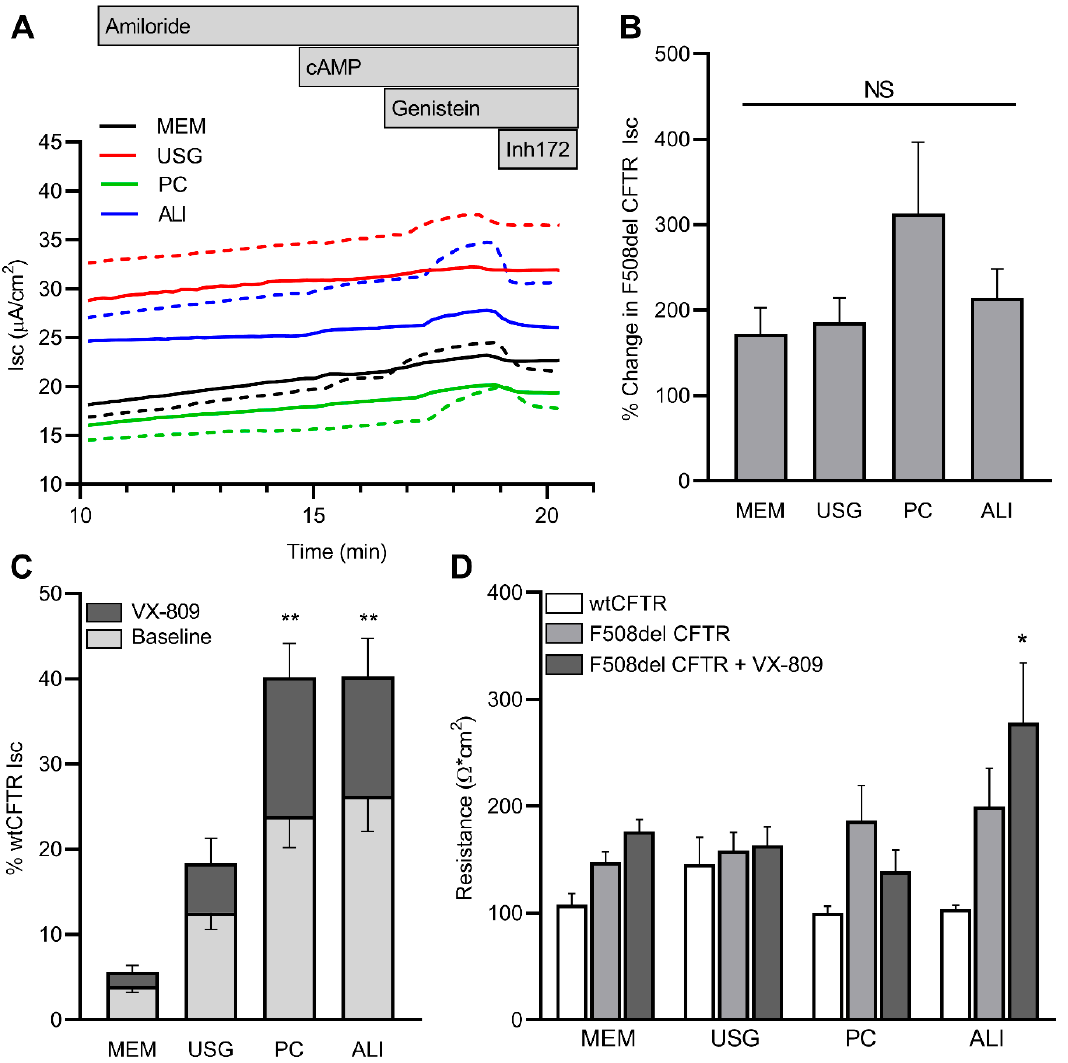
Figure 5. Media selection does not alter F508del CFTR rescue by VX-809; however, it does impact normalization of modulated CFTR function against wtCFTR. Cells grown in four media and treated for 72 h with vehicle or VX-809 were mounted in Ussing chambers and CFTR function was quantified under voltage clamp conditions. Representative tracings of corrected (dashed) and uncorrected (solid) F508del CFTR are shown in ( A ), while the VX-809-induced improvement in CFTR function is quantified in ( B ) as a relative change compared to vehicle. When normalized against media-specific wtCFTR function, there is a significant apparent difference in baseline (light grey) and VX-809-modulated (dark grey) F508del CFTR function ( C ); CFTR function is defined as cAMP- and genistein-dependent Isc, as presented in Figure 4B,D. Baseline resistance measurements for all conditions are shown in ( D ), with only VX-809-treated F508del inserts grown in ALI media being statistically different across the cohort. n = 3–4 inserts per condition. * p < 0.05; ** p < 0.01; NS: Not Significant vs. MEM by one-way ANOVA with Dunnett’s multiple comparison test ( B , C ), or two-way ANOVA with Tukey’s multiple comparisons test ( D